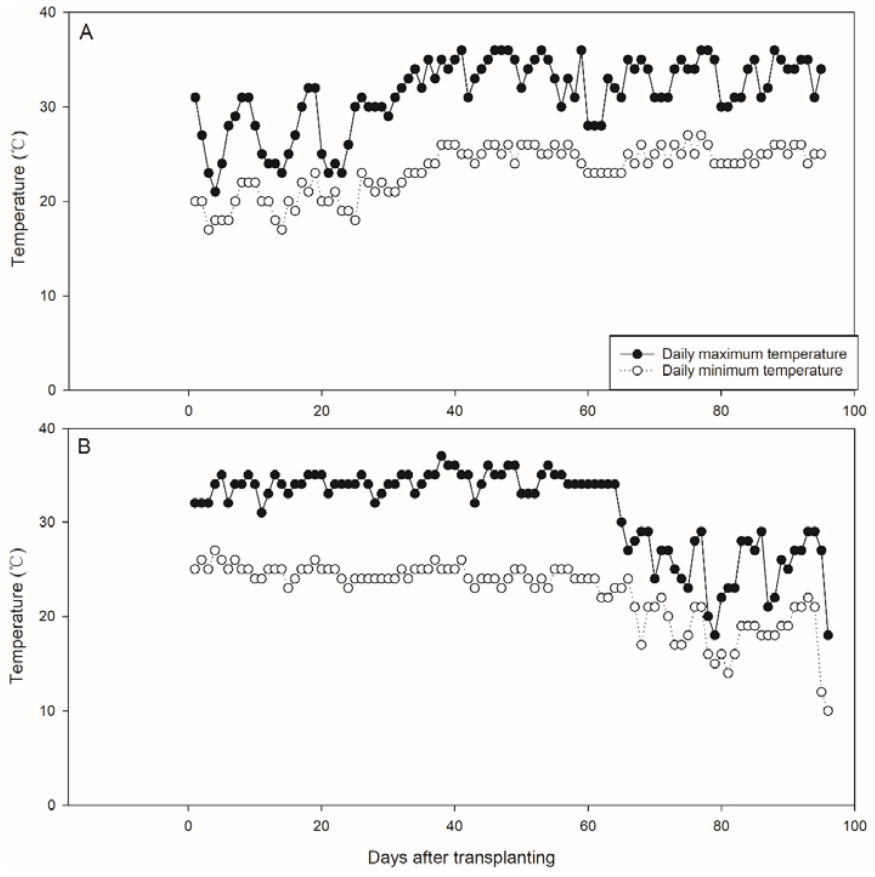
Figure 1. The daily temperature between transplanting and harvest; ( A ) for the early lug; ( B ) for the late lug.